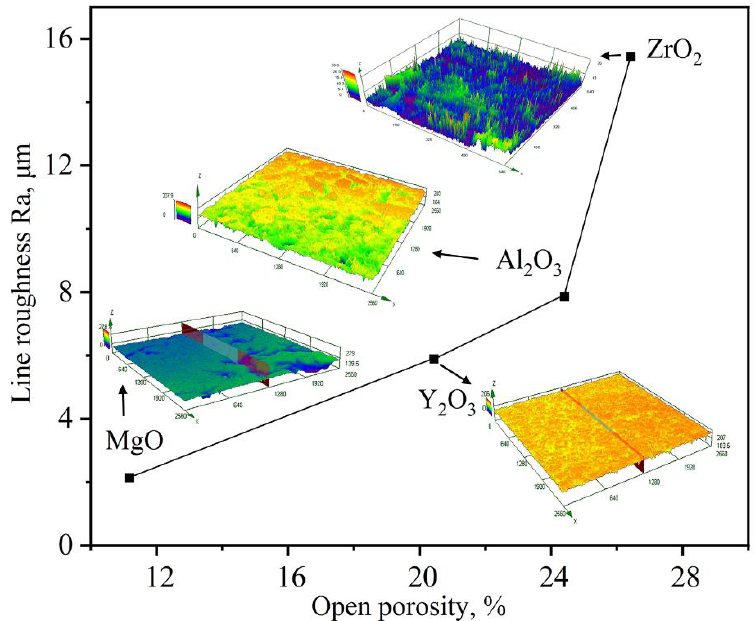
Figure 13. The relationship between the surface roughness values (Ra) and the levels of open porosity of the various oxide ceramics.